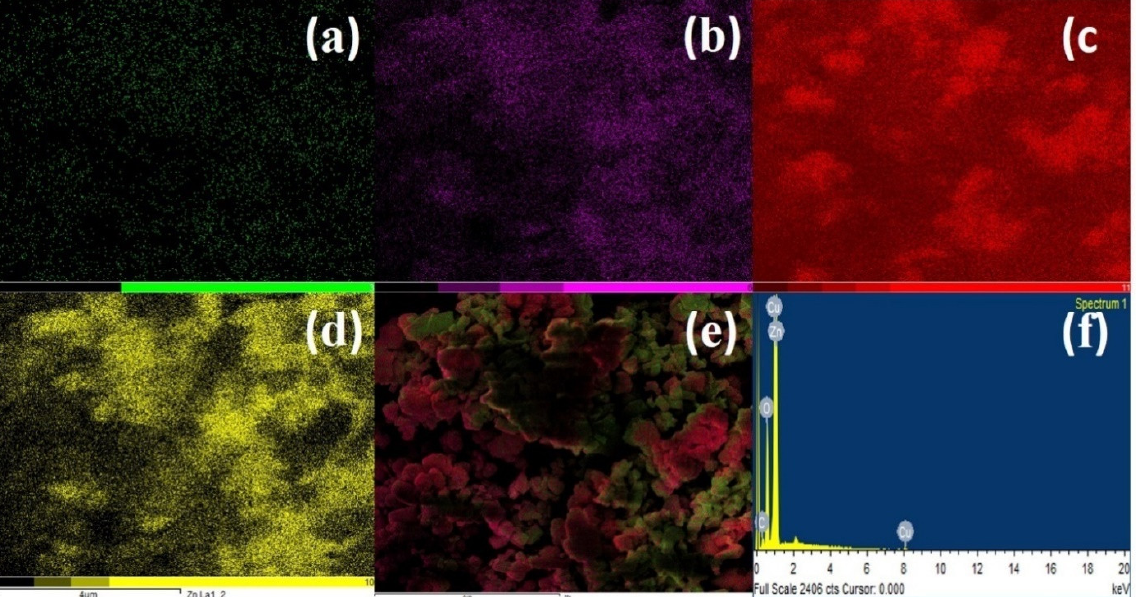
Figure 4. Elemental mapping of rGO@ZnO–Cu. ( a ) C, ( b ) O, ( c ) Cu, ( d ) Zn, and ( e ) all mapped elements, ( f ) EDAX analysis of rGO@ZnO–Cu.